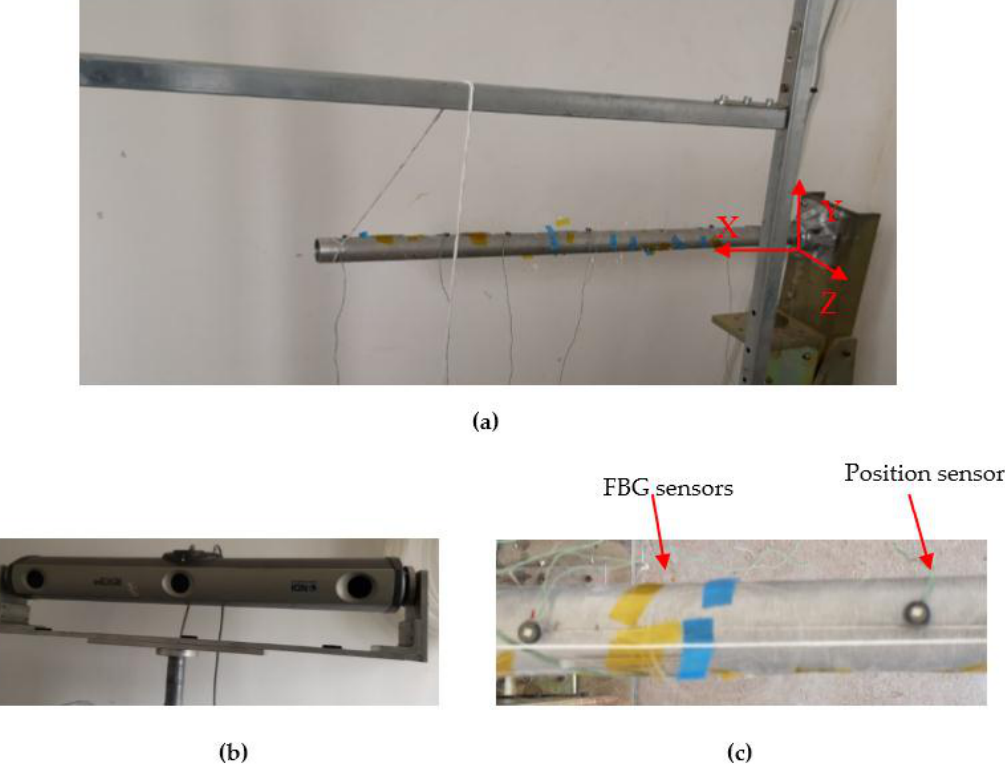
Figure 5. The component of the experimental platform: ( a ) A loading on the end node of the beam construction; ( b ) NDI Optrotrak Certus; ( c ) Position sensors and Fiber Bragg Grating (FBG) sensors. Table 6. Static loading